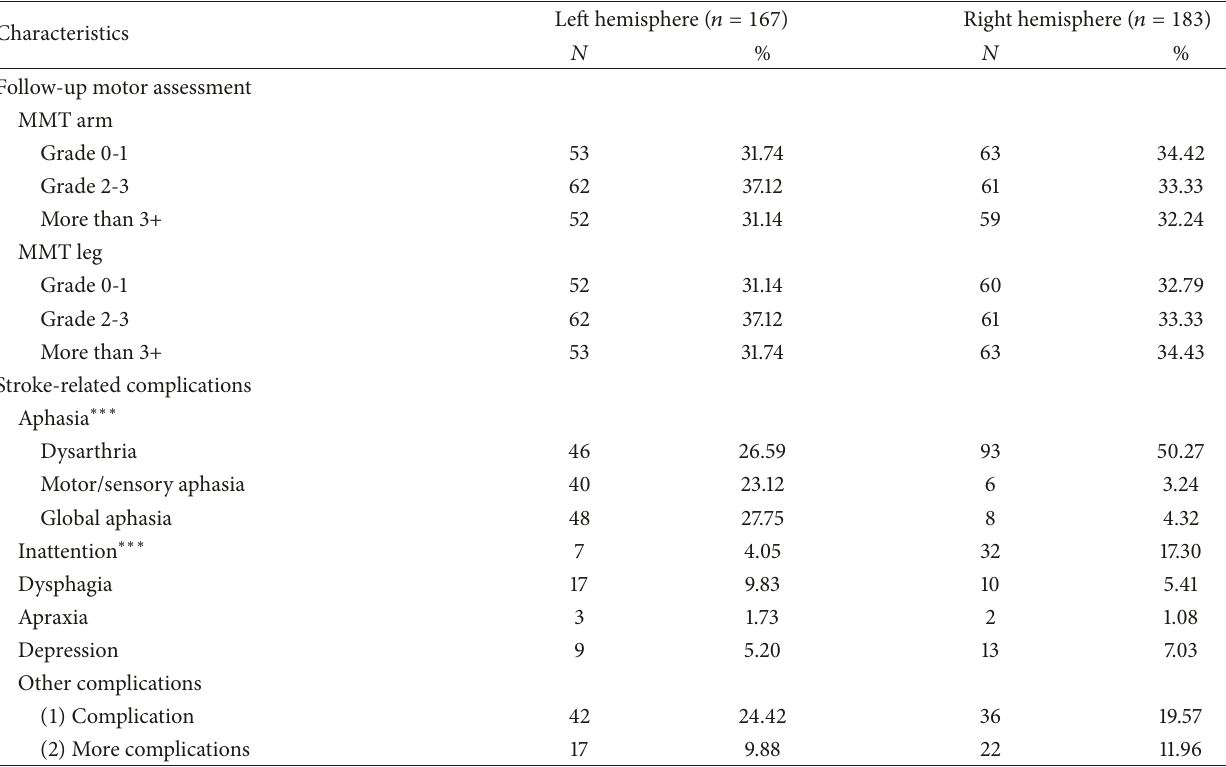
Table 2: Comparison of six-month follow-up motor assessment and poststroke complications between left- and right-sided hemispheric lesions.